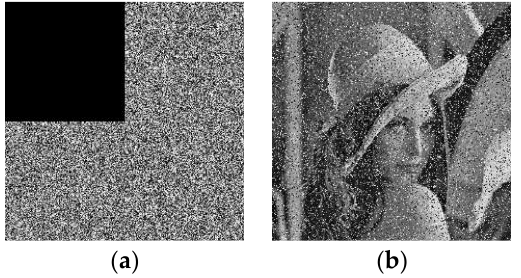
Figure 16. The removal of a 128 × 128 sub block: ( a ) encrypted image and ( b ) decrypted image.